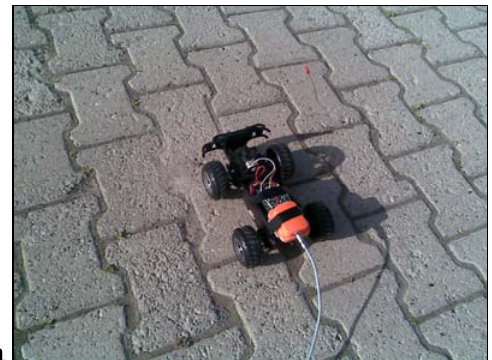
Figure 5. Terrain types: (a) pavement, (b) asphalt, (c) grass and (d)